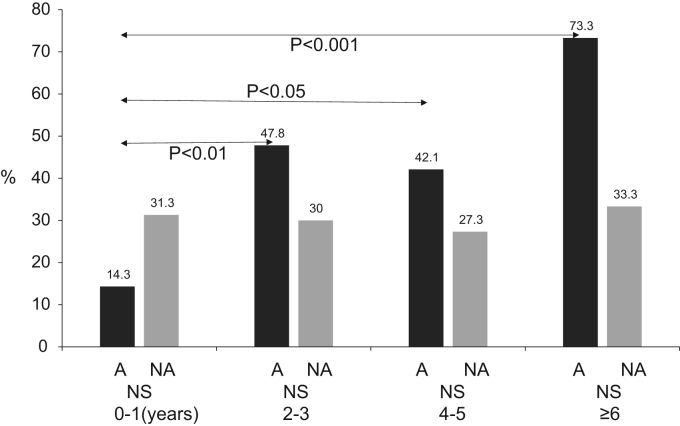
Nasal discharge eosinophils by age. A, Asthma group; NA, Non-asthma group. The positive nasal discharge eosinophil rates in the A group were significantly higher in patients aged 2–3 years, 4–5 years, and ≥ 6 years than in patients aged 0–1 years (p< 0.05-0.001, chi-square test).